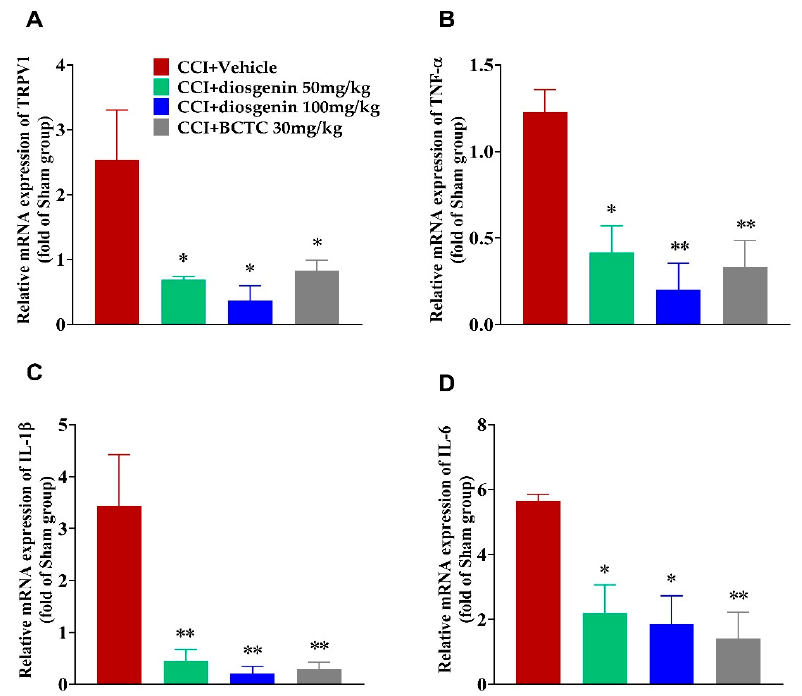
Figure 7 . Relative quantification of ( A ) TRPV1, ( B ) TNF- α , ( C ) IL-1 β , and ( D ) IL-6 mRNA levels in the DRG of different groups, determined using the 2 - ΔΔ Cq method following normalization to inter- nal controls. Data are presented as mean ± standard error of mean (all n = 3). * p < 0.05 and ** p < 0.001, Dunnett’s test following one-way ANOVA versus the CCI + vehicle group. CCI: chronic con- striction injury; TRPV1: transient receptor potential vanilloid 1; TNF- α : tumor necrosis factor alpha; IL: interleukin.